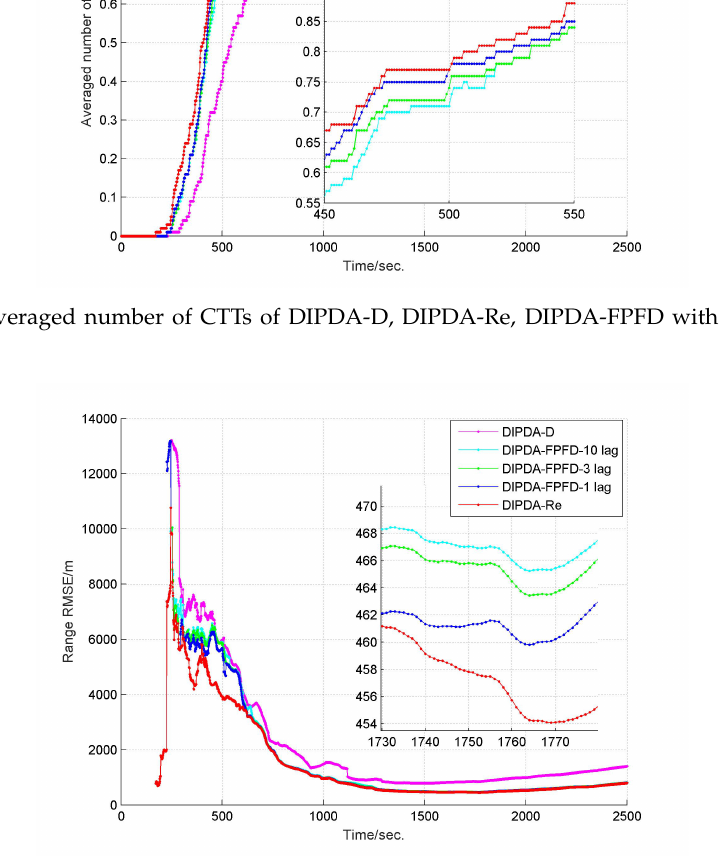
Figure 14. RMSE of estimated target range of DIPDA-D, DIPDA-Re, DIPDA-FPFD with different lags (case